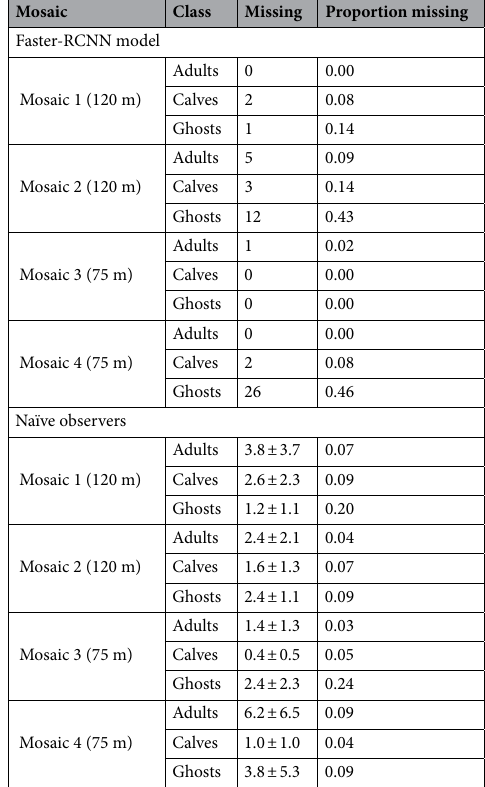
Table 3. Number and proportion of caribou adults, calves, and ghosts that were missed by the Faster-RCNN and the pool of naïve observers (mean ± SD) per